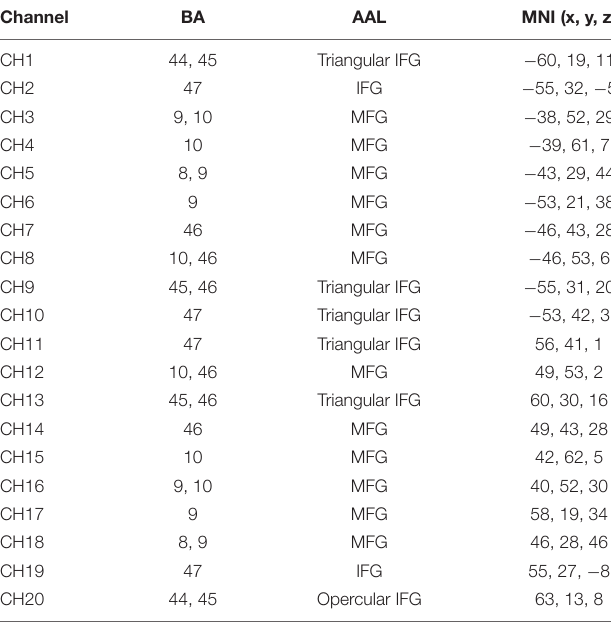
TABLE 1 | Channels corresponding to BA/AAL/MNI label.